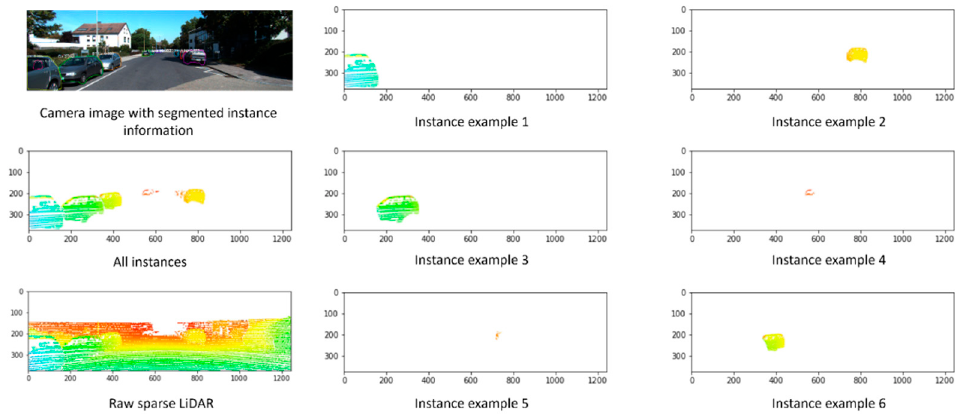
13 of 18 Figure 10. Instance segmentation mask loss on both training and validation datasets over different epochs. Figure 11 shows the performance of the instance segmentation model on a randomly selected frame from the KITTI dataset. The top left image shows the frame with the in ‐ stance mask placed on each object. The figure also shows the LiDAR sparse point cloud and instances examples. Depth completion neural networks can work on each instance